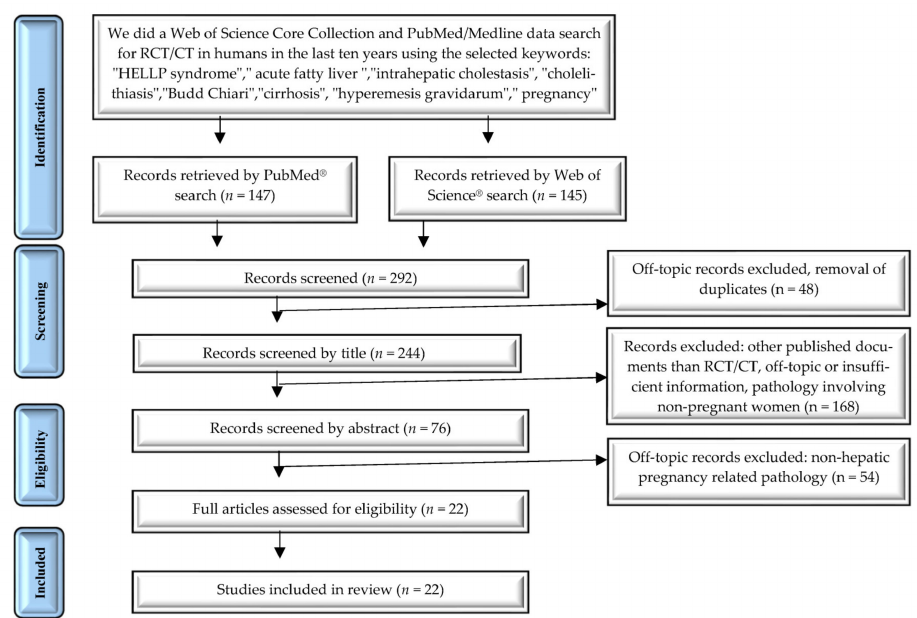
Figure 2. PRISMA diagram: systematic search and study selection